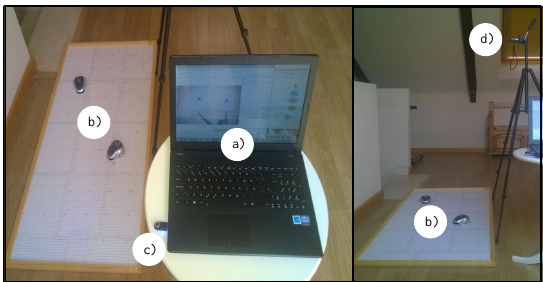
Figure 8. Components of the test laboratory: ( a ) controller; ( b ) mOway mobile robots; ( c ) RF interface; and ( d ) video camera.